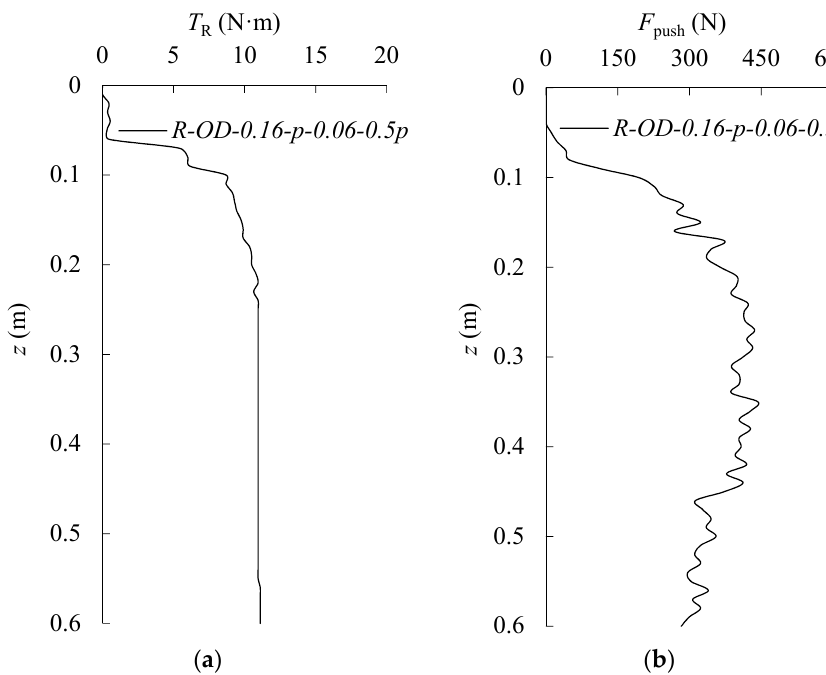
Figure 10. The test results of TN-5. ( a ) Recycling torque. ( b ) Vertical force on shaft.